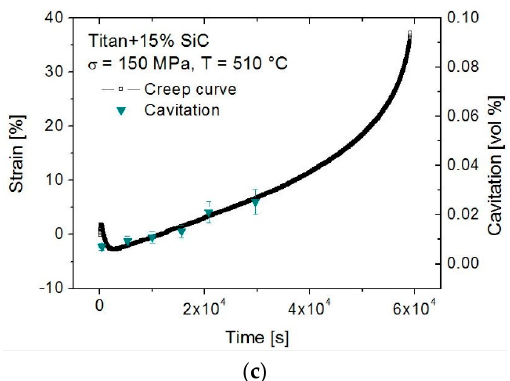
Figure 6. Relation of the total cavitation to creep curve: ( a ) Al-MMC; ( b ) and ( c ) Ti-MMC.